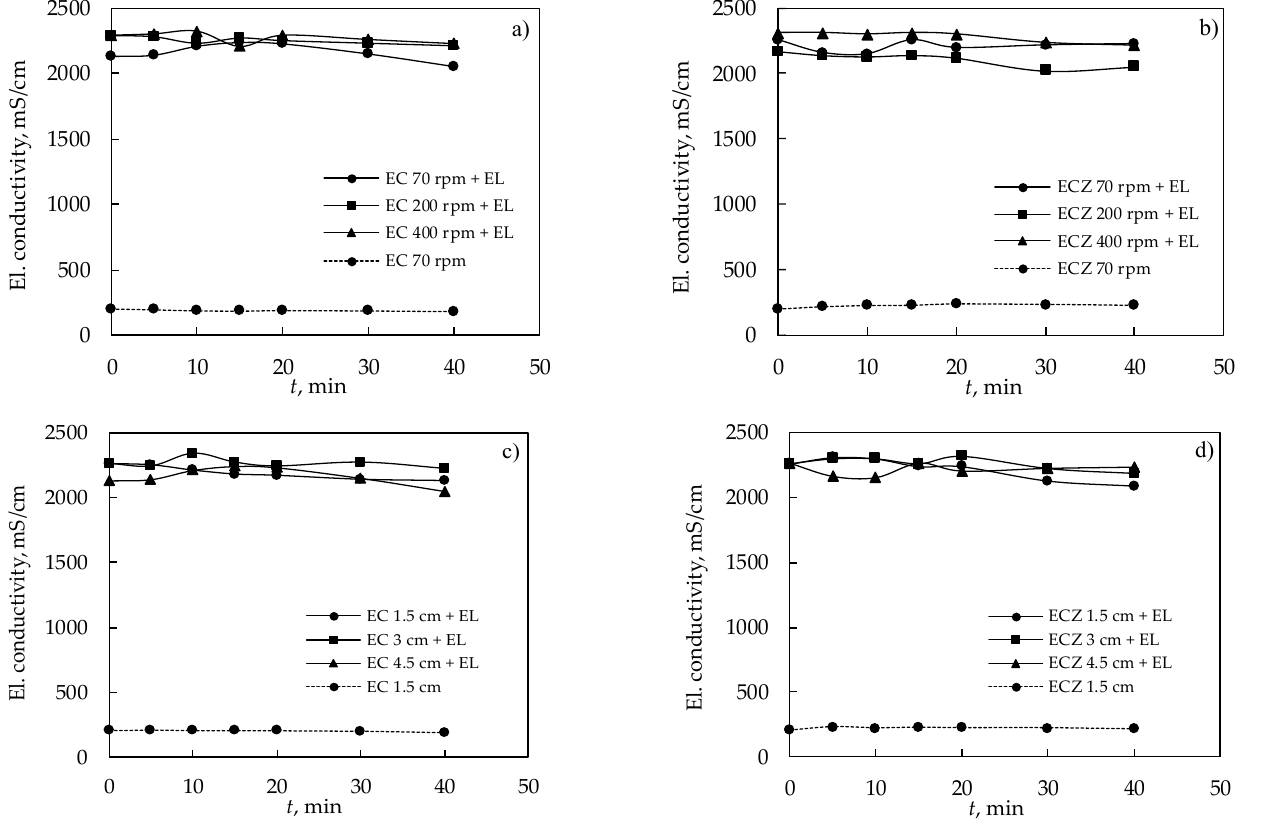
Figure 2. Change of el. conductivity in solution during EC process at different: ( a ) stirring speed; ( b ) stirring speed with the addition of zeolite; ( c ) electrode distance; ( d ) electrode distance with addition of zeolite. Note: mark EL means the addition of electrolyte.